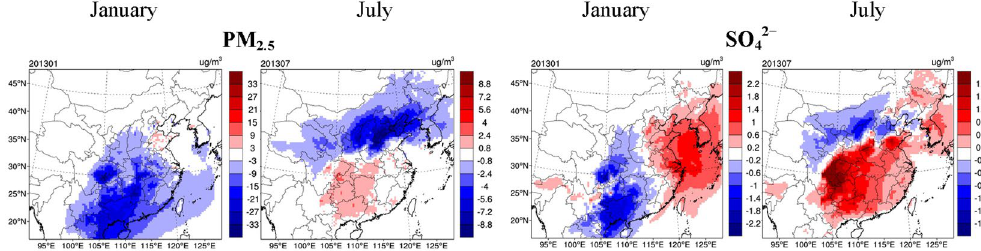
Figure 6. Overall impact of aerosol-cloud interactions due to anthropogenic aerosols, and the cloud processing of aerosols (wet scavenging, cloud chemistry) on concentrations of PM 2.5 and SO 42– , determined from the scenarios of BASE and PRSC10_NWDAQ (BASE minus PRSC10_NWDAQ). This figure is produced using the NCAR Command Language (Version 6.2.1) [Software]. (2014). Boulder, Colorado: